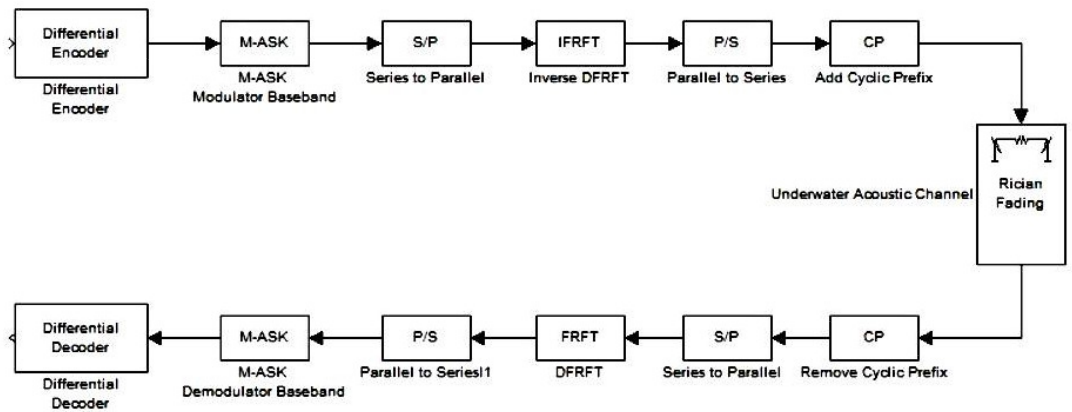
Figure 3. ASK FrFT-OFDM System model. A schematic diagram for ASK-OFDM based on FrFT for UWA